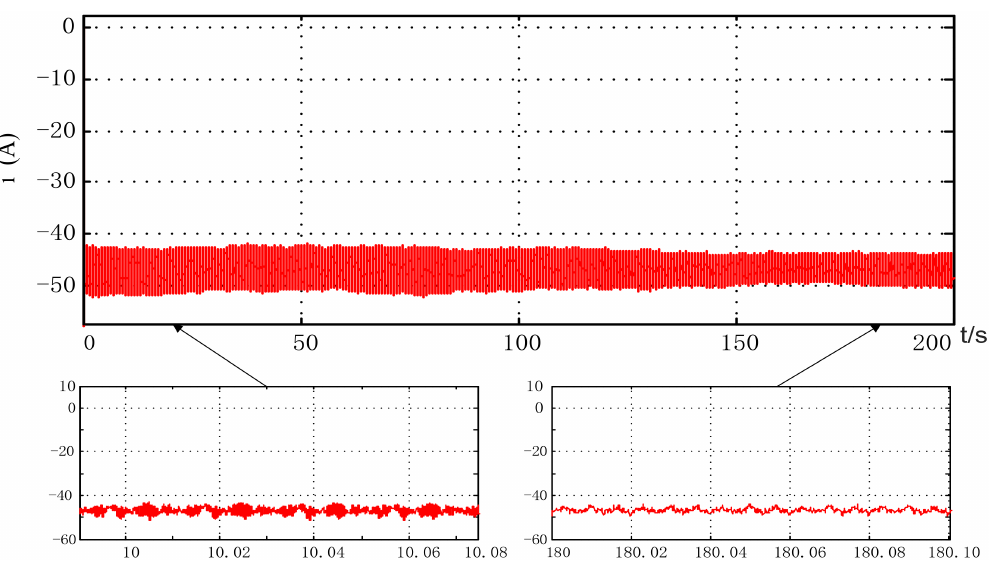
Figure 9. The DC-link